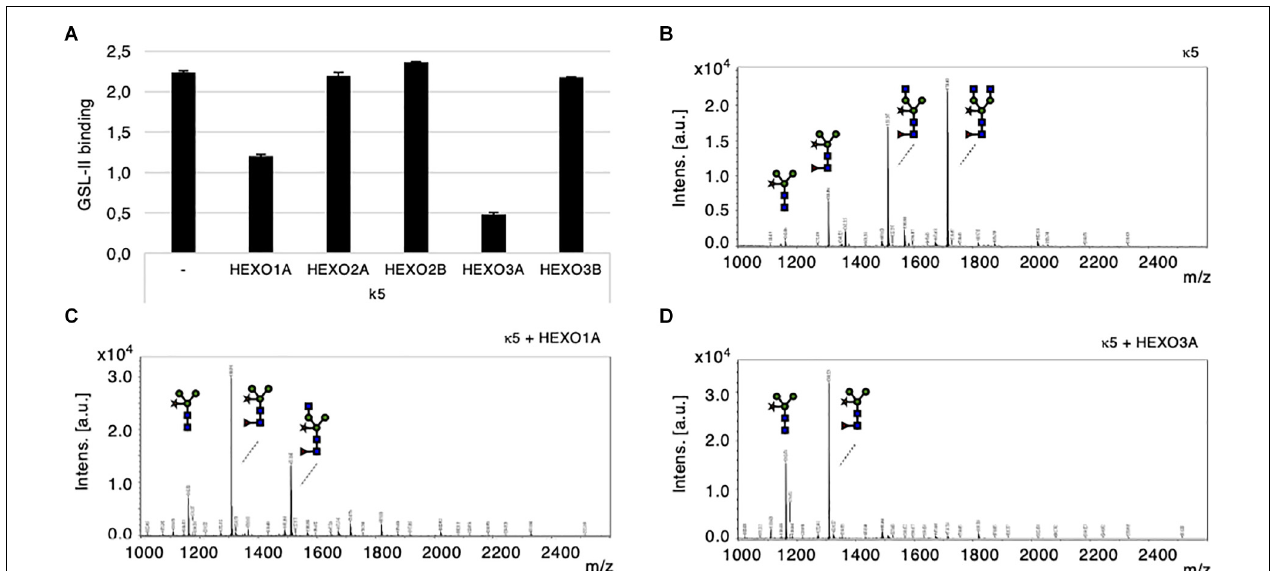
FIGURE 4 | Cleavage of terminal GlcNAc residues by N. benthamiana HEXOs. Kappa-5 was co-expressed with p19 and different HEXO genes in wild-type plants. After isolation of the apoplast fluid (at 6 dpi) the glycan composition of kappa-5 was analyzed. (A) Griffonia simplicifolia lectin II (GSL-II) binding assay for detection of terminal GlcNAc. Lectin binding is measured as absorbance at 450 nm. (B–D) Kappa-5 was purified from the apoplast fluid and the N-glycan composition was analyzed by MALDI-TOF-MS. MS profiles are given for N-glycans of wild-type kappa-5 (B) or upon co-expression of HEXO1A (C) or HEXO3A (D) . m/z refers to mass-to-charge ratio.